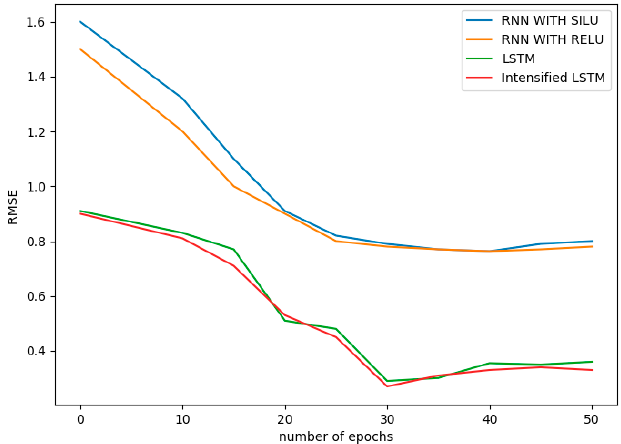
Figure 8. Comparison of RMSE for Neural Network-based prediction models.